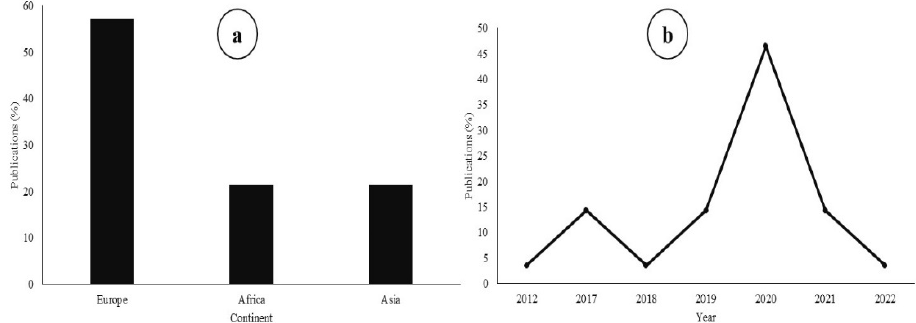
Figure 1. Distribution of publications according to continents ( a ) and years ( b ). From all studies identified, 17 species of fish including 12 carnivorous (70.59%) and 5 omnivorous (29.41%) were tested for nutrition with BSFM. The species with the highest occurrence (27%) is Oncorhynchus mykiss (Walbaum, 1792). Species Dicentrarchus labrax (Linnaeus, 1758) and Oreochromis niloticus (Linnaeus, 1758), each represent 10% of the publications (Figure 2).